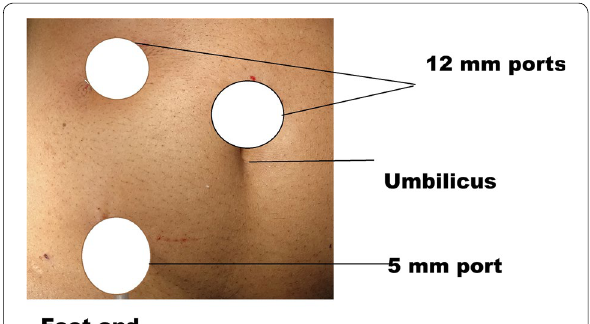
Fig. 2 Port positions prior to